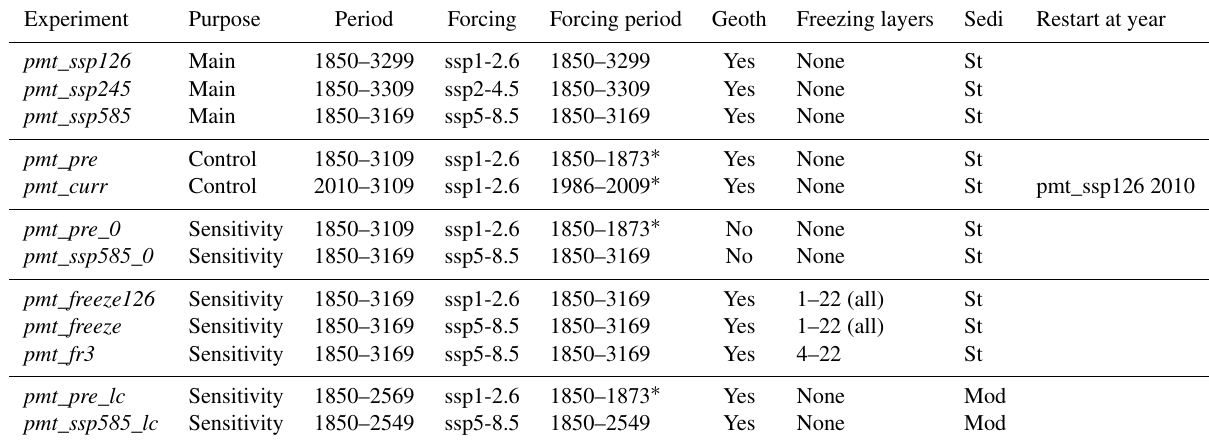
Table 1. Performed experiments. The forcing for the three SSPs is identical for the period 1850–2009. ∗ : forcing repeated cyclicly. “Geoth”: geothermal heat flux included. “Freezing layers”: freezing of porewater allowed for these layers. “Sedi”: sediment heat capacity and conductivity from “St” standard JSBACH or “Mod” modified as described in the discussion. Experiment Purpose Period Forcing Forcing period Geoth Freezing layers